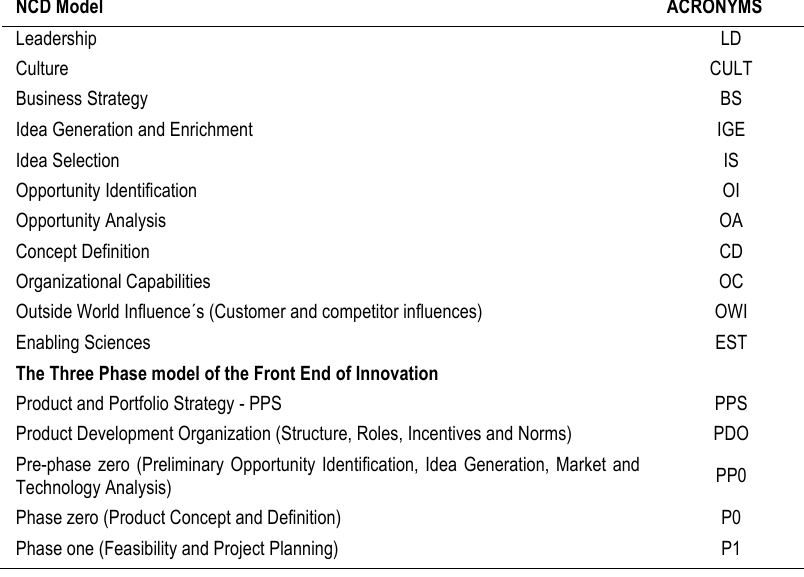
Table 2. List of acronyms used for the categories of analysis NCD Model